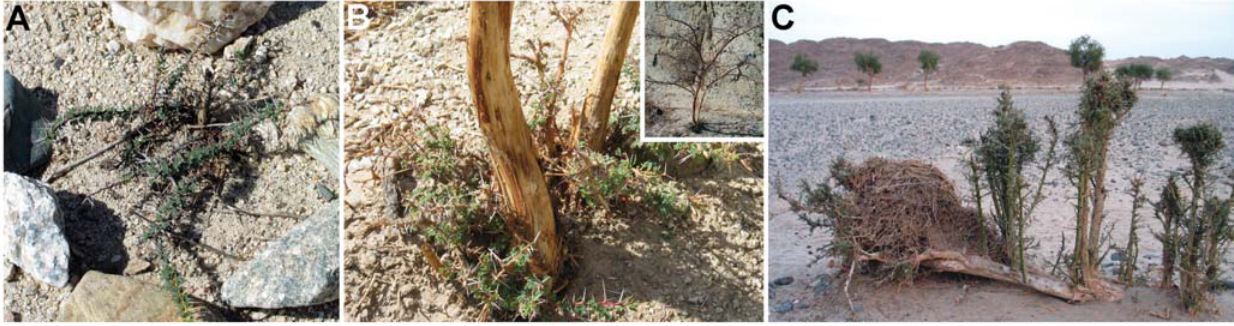
Figure 4. Sprouting. A Saplings frequently resprout after droughts and/or browsing. This individual has been intentionally encircled by stones. B An Acacia tortilis has to start all over again. C Also in Balanites aegyptiaca root and trunk sprouting seems to be an important